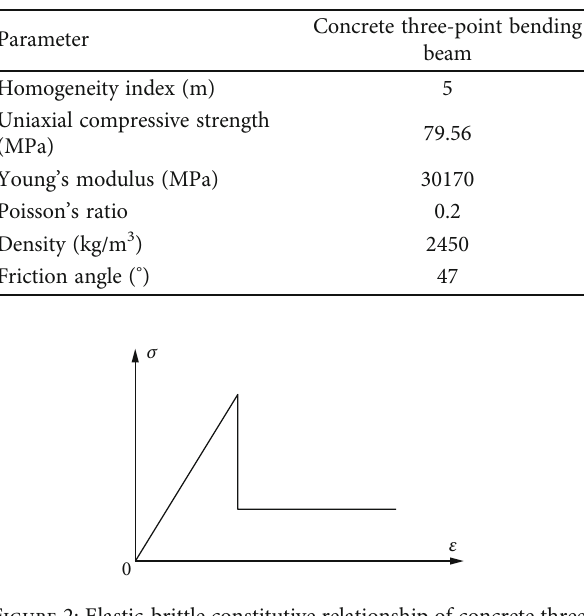
Figure 1: Numerical model. Table 1: Physical and mechanical parameters of concrete three- point bending beam.